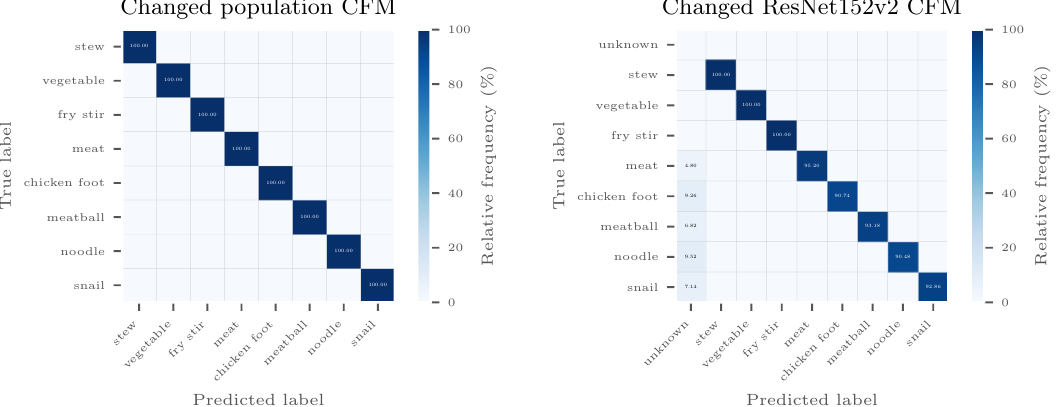
Figure A7. The population ( a ) and ResNet ( b ) CFM from after applying CRT. CFMs are obtained from the ENG population and VireoFood-172 subset.